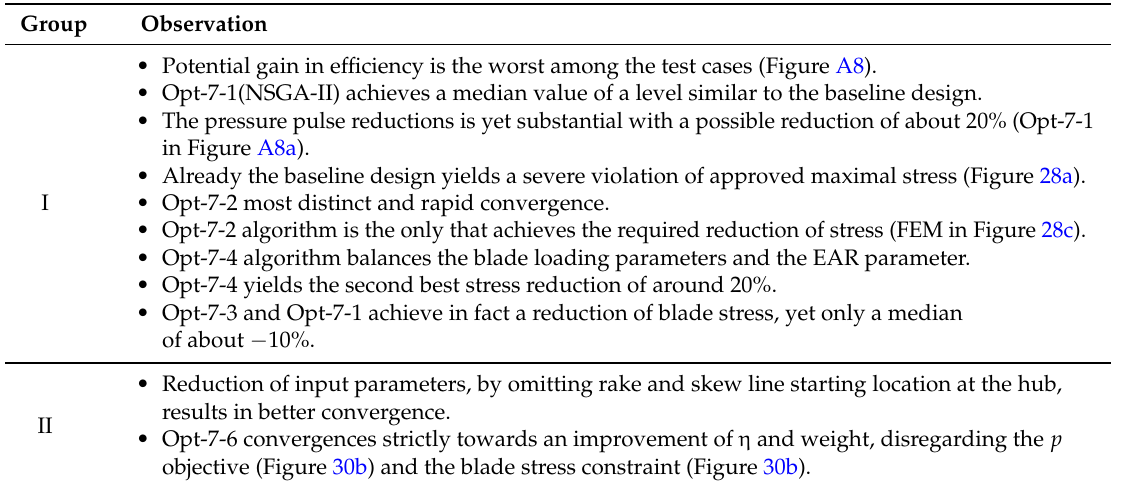
Table 17. Potential improvement and convergence observations of Opt-7. Group